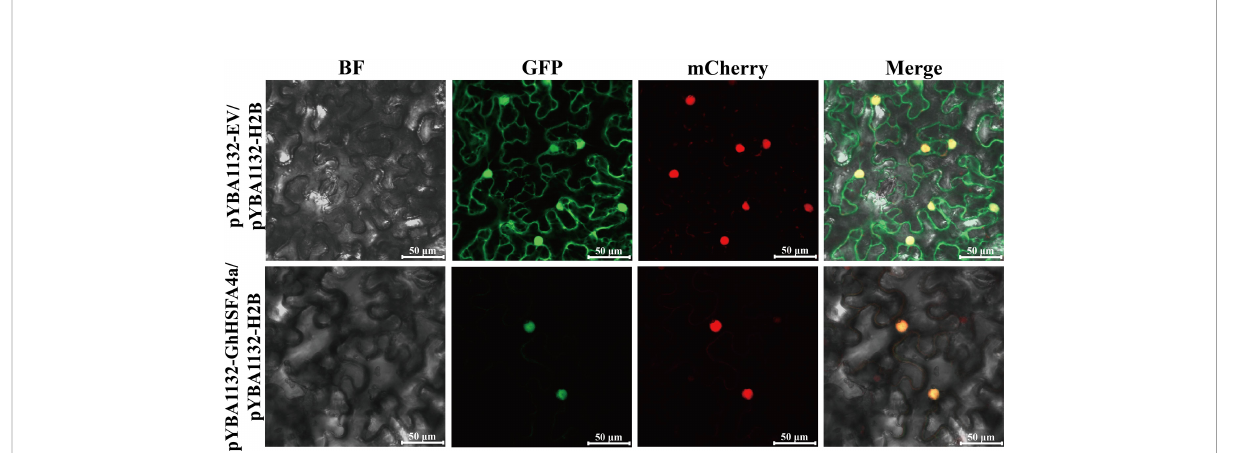
resistance pathway, we used RNA-seq and analyzed the DEGs between pTRV2:: 00 and pTRV2:: GhHSFA4a seedlings (Figure 5). After fi ltering the original read quality, 38 Gb of clean sequence data were obtained for the two samples (5.81- 6.72 Gb of clean reads for each sample). Using the G. hirsutum TM-1 transcriptome as the reference genome (ASM98774v1), 93.31-94.16% of the clean reads were mapped to the reference genome. Through standardization and screening of the read count, we identi fi ed 814 DEGs (424 upregulated and 390 down